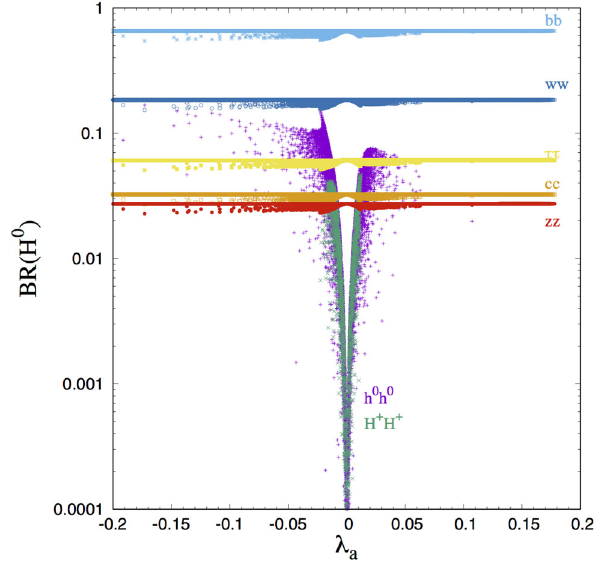
Fig. 7 Branching ratio of H 0 → b ¯ b , c ¯ c , τ + τ − , W + W − , Z Z , h 0 h 0 and H ± H ∓ as a function of λ a . Our inputs are λ ≈ 0 . 52, λ b = 1, v = 1 GeV and 0 . 1 ≤ μ ≤ 0 . 52 (GeV) ( m t